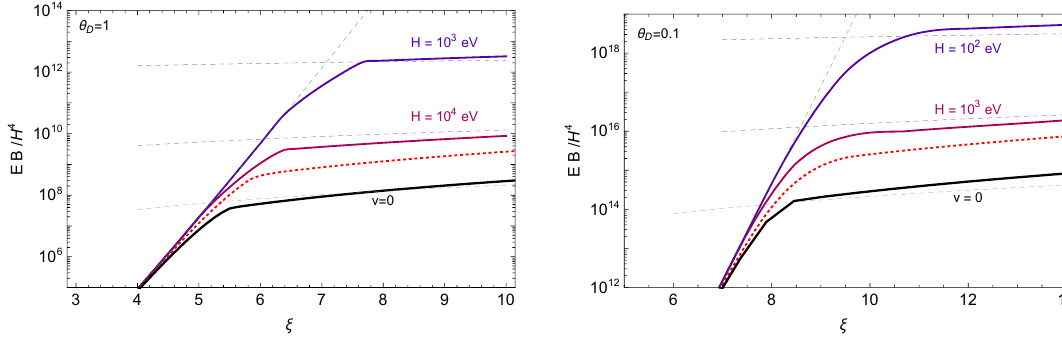
Figure 2 . Upper bound on gauge field production including backreaction from SM leptons with unit charge (left) and millicharge θ = 0 . 1 (right). The black contour corresponds to a vanishing D Higgs vev, including the backreaction of all three massless SM charged leptons on the gauge field production. The coloured contours correspond to a Higgs vev of 246 GeV for different values of the Hubble parameter H , with the dotted red line indicating the limit H → ∞ . Here we include only the electron as the lightest charged SM particle. The dashed lines show our analytical approximations, given by eq. (2.5) (green), (4.4) (grey) and (4.9) (purple) with β = 1 and ˜ β = 3